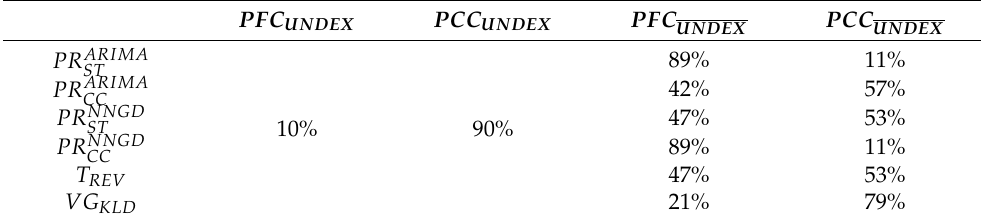
PCC UNDEX UNDEX 89% 11% 42% 57%